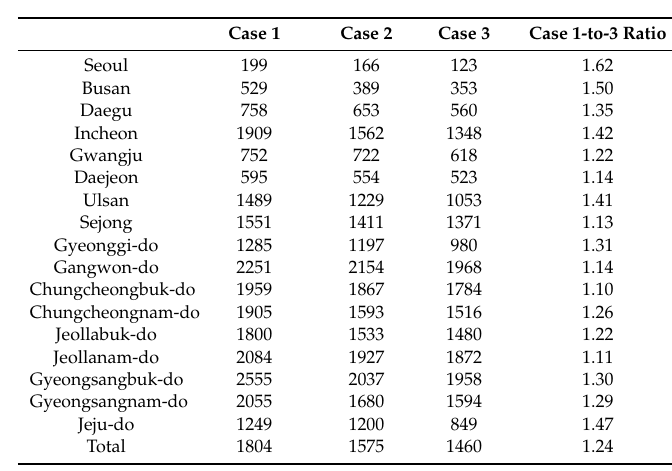
Table 3. Average distance to the nearest grocery store by case (scenario) and upper-level administrative district (Metropolitan Si and Do in